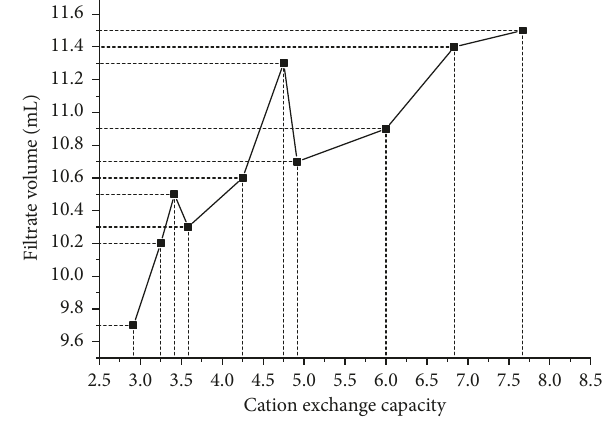
Figure 4: Curve of filtration volume.